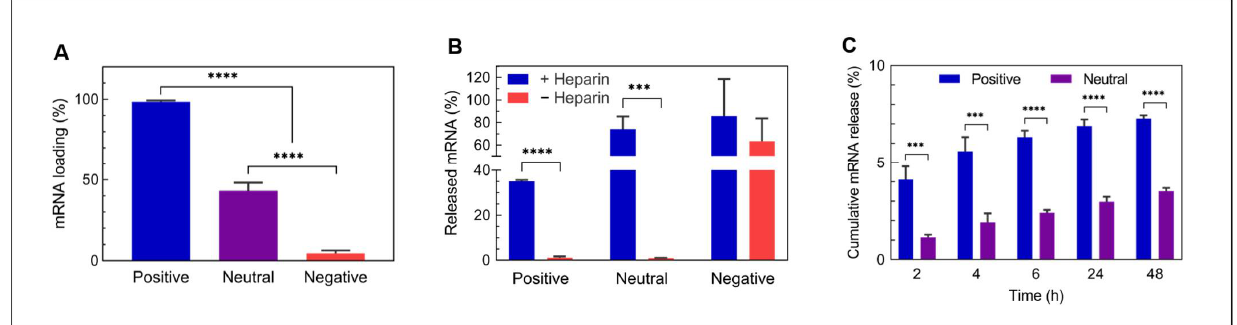
Figure 2. mRNA loading and release from gelatin nanoparticles. ( A ) Loading efficiency for differ- ently charged gelatin nanoparticles, calculated based on the mRNA remaining in the supernatant ( n = 6), ( B ) competitive mRNA decomplexation from gelatin nanoparticles with heparin ( n = 3) and ( C ) cumulative spontaneous mRNA release in aqueous suspension ( n = 3). Release data for negatively charged nanoparticles was not included, due to mRNA amounts below the detection limit. Statisti- cal significance is shown as *** p < 0.001 and **** p < 0.0001.